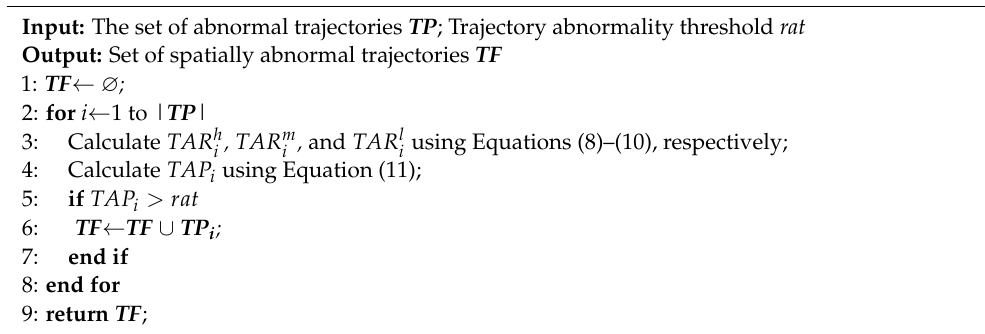
Algorithm 3: Trajectory abnormality rate acquisition and abnormality judgment